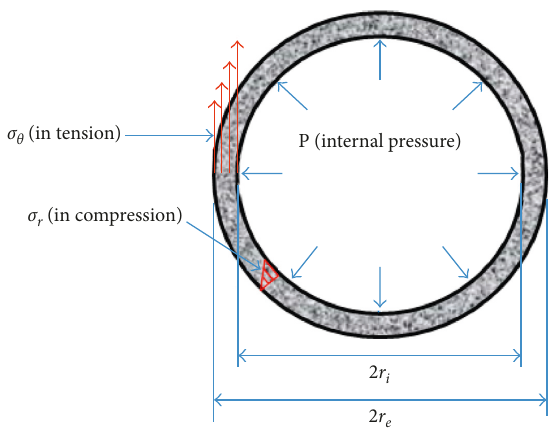
Figure 3: Distribution of internal stress and simplification for fracture